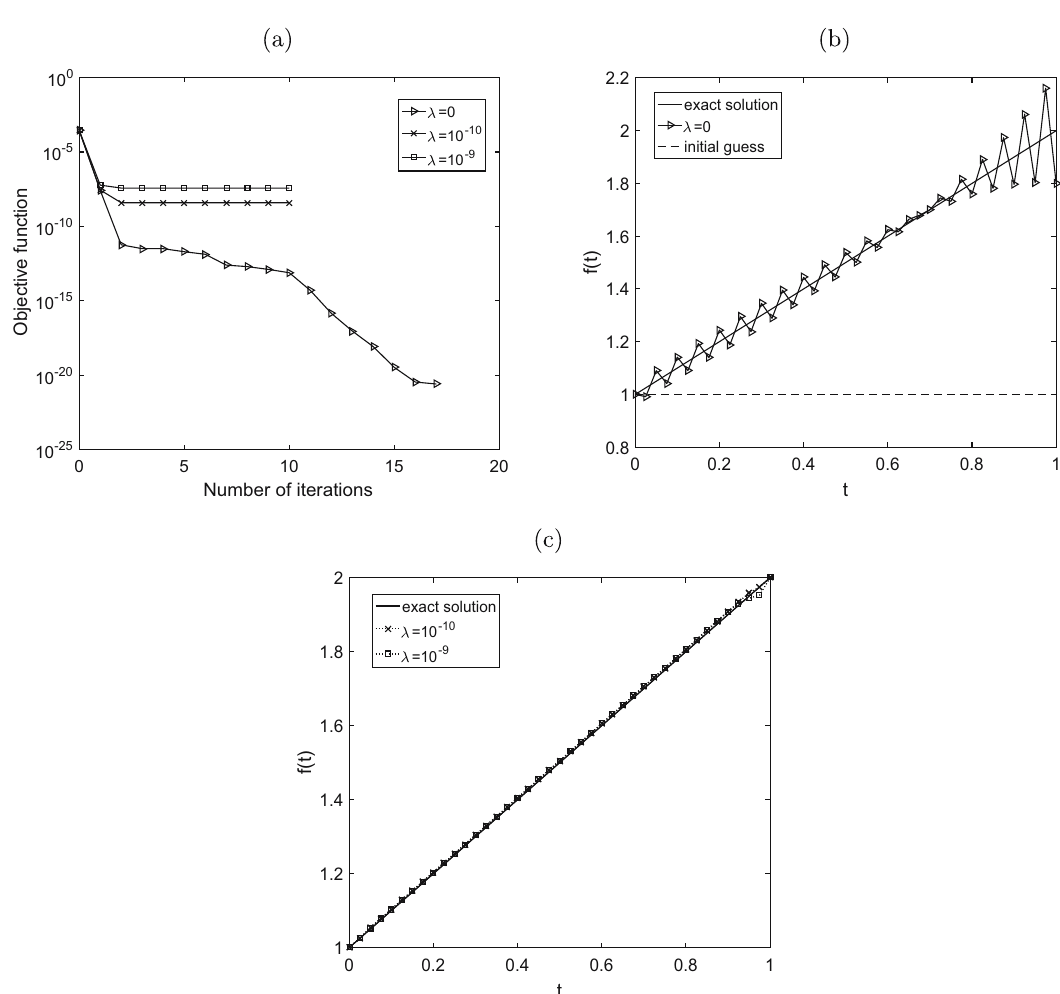
Figure 3: ( a ) The J ( 73 ) and the exact ( 77 ) and approximate ( ) f t , for = p 0 with λ : ( b ) 0 and ( c ) 10 , 10 −10 −9 , for Example